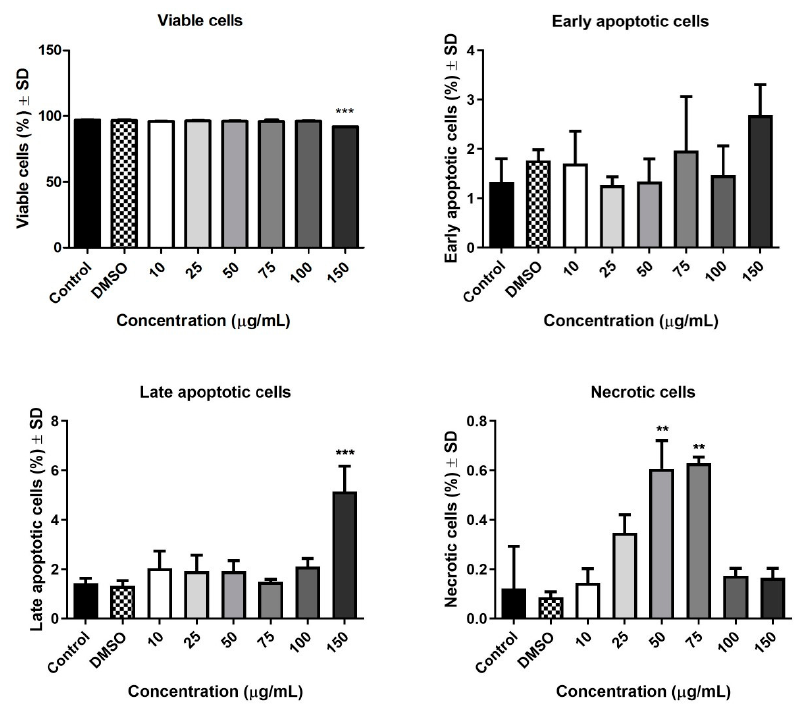
Figure 9. The pro-apoptotic potential of Pg extract (10, 25, 50, 75, 100, and 150 µg/mL) on A549 human lung adenocarcinoma cells. The bar graphs are expressed as the percentage (%) of viable cells, early apoptotic cells, late apoptotic cells, and necrotic cells related to control cells. ** p < 0.01, *** p < 0.001 .